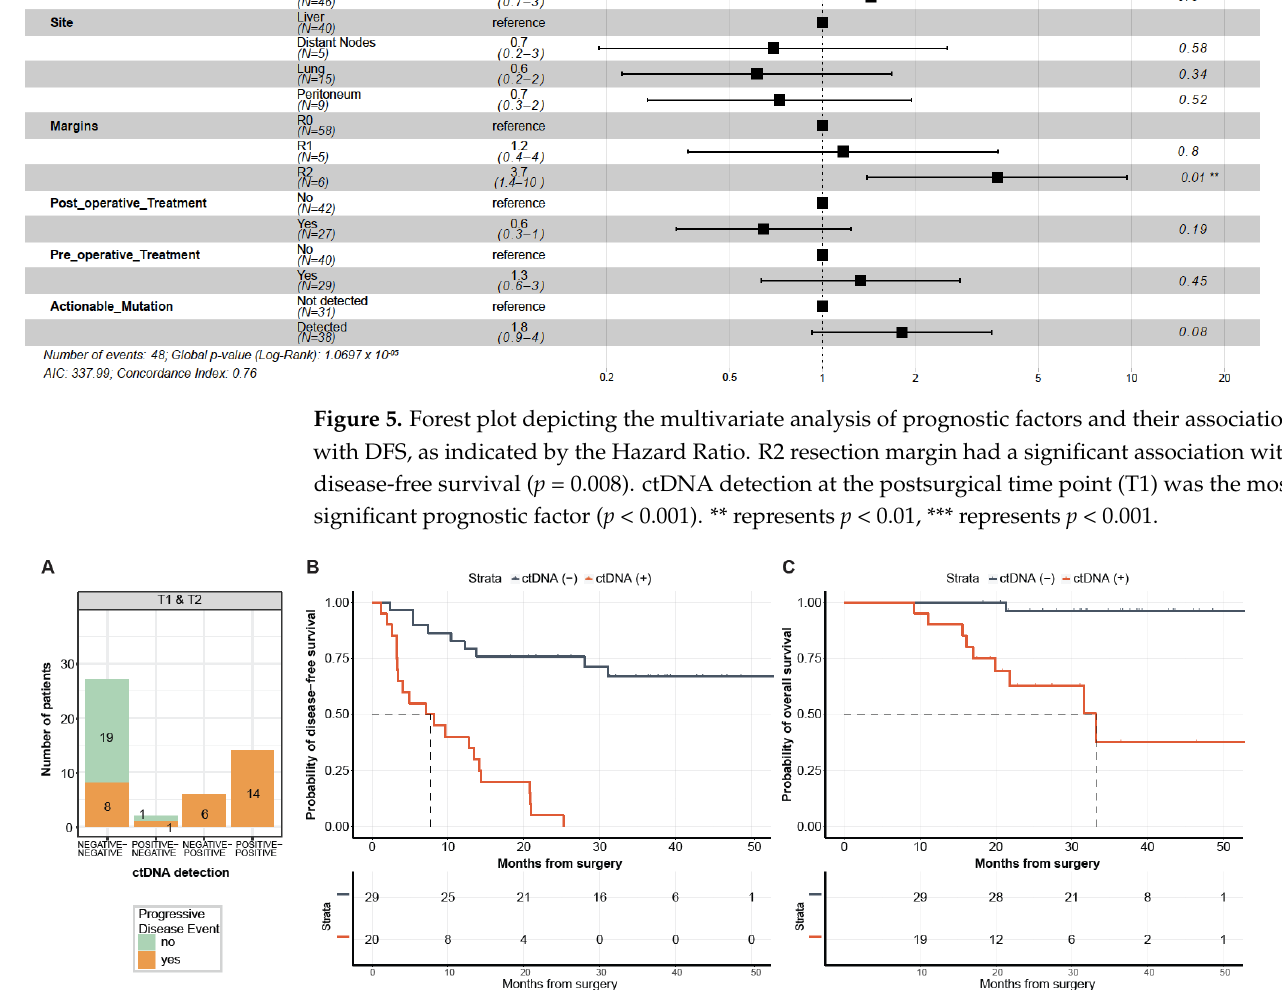
Figure 6. ( A ) ctDNA detection rates across two time points (T1 + T2). ( B , C ) Kaplan – Meier estimates for 49 patients monitored by FoundationOne ® Tracker across two time points (T1 + T2) stratified by ctDNA detection at the last or follow-up time point (T2).